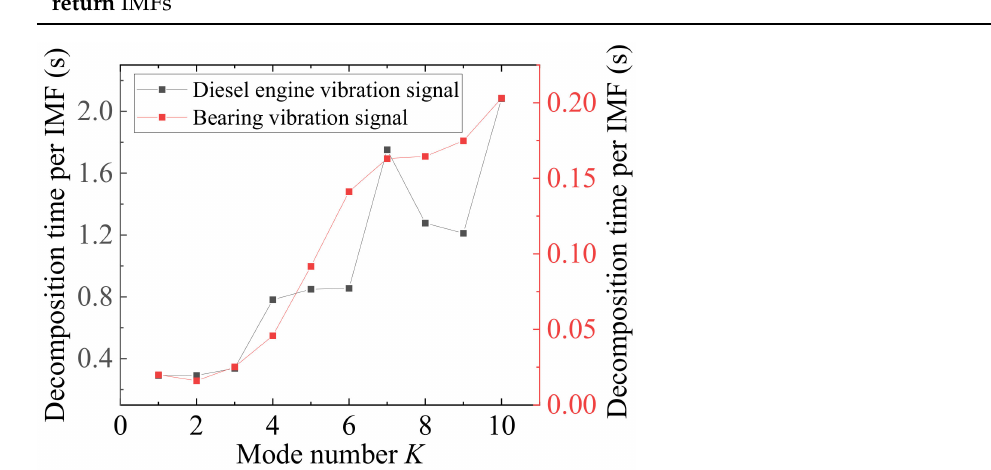
Figure 2. Decomposition time per IMF of VMD. The curve data come from the average of normal signals of various speeds. The engine data come from the experiment of Section 3. The bearing data come from the bearing dataset of Case Western Reserve University